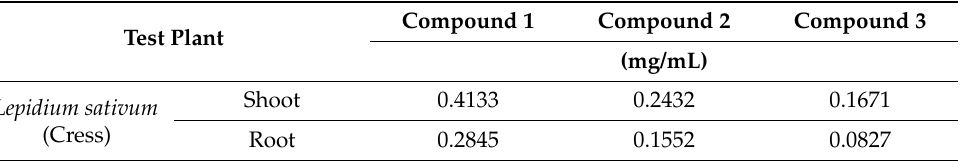
Figure 7. Phytotoxic potentials of compound 3 against the shoot and root growth of Lepidium sativum . The values are the mean ± standard error (SE) from two different studies with 10 seedlings for each treatment. Different letters indicate significant variations according to Tukey’s HSD test at the 0.05 level of significance. Table 2. The I 50 values (concentrations resulting in 50% growth restriction) of compound 1 , 2 , and 3 against the test plant .